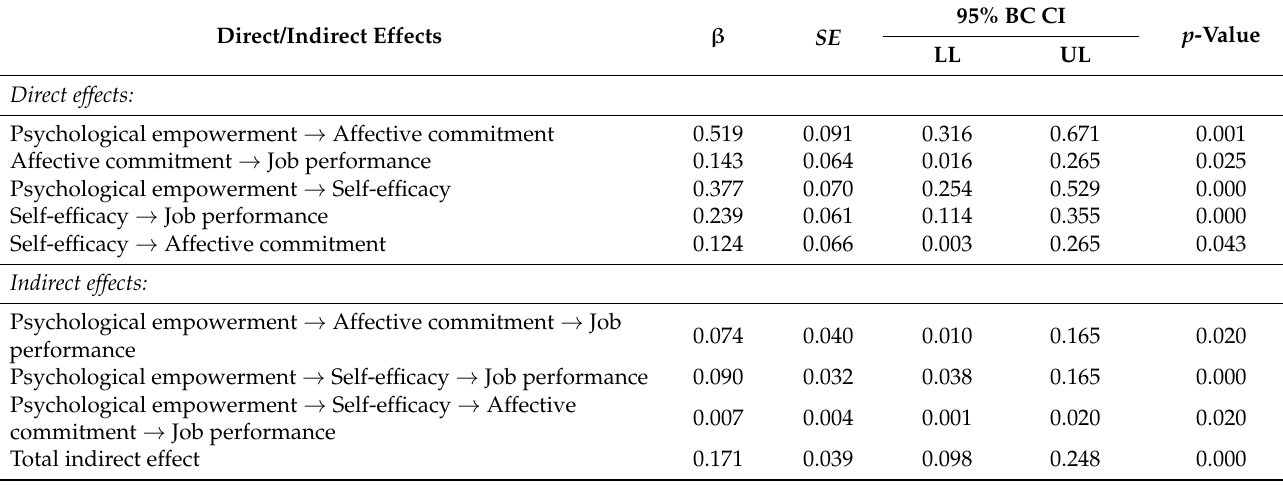
Table 5. Results of the hypotheses testing.